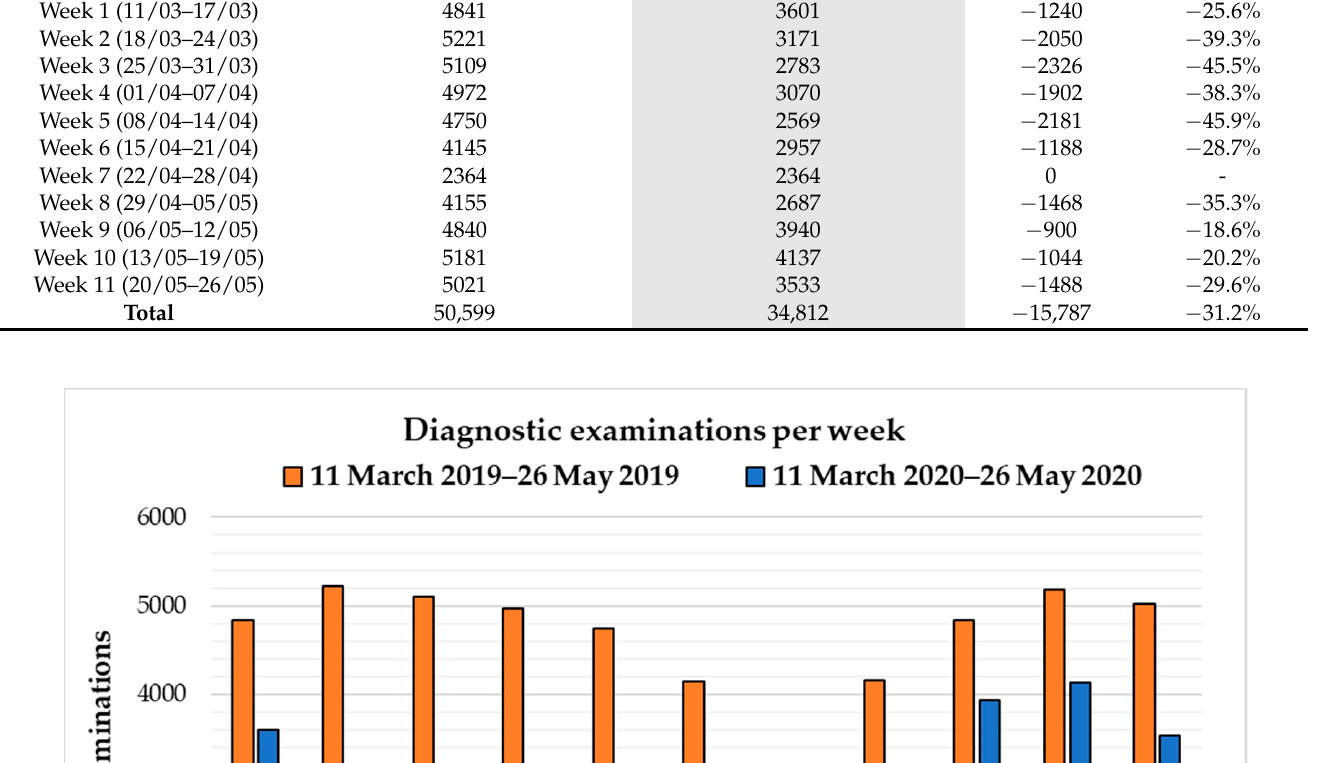
Table 2. Number of diagnostic investigations performed per week within the ordinary activity (11